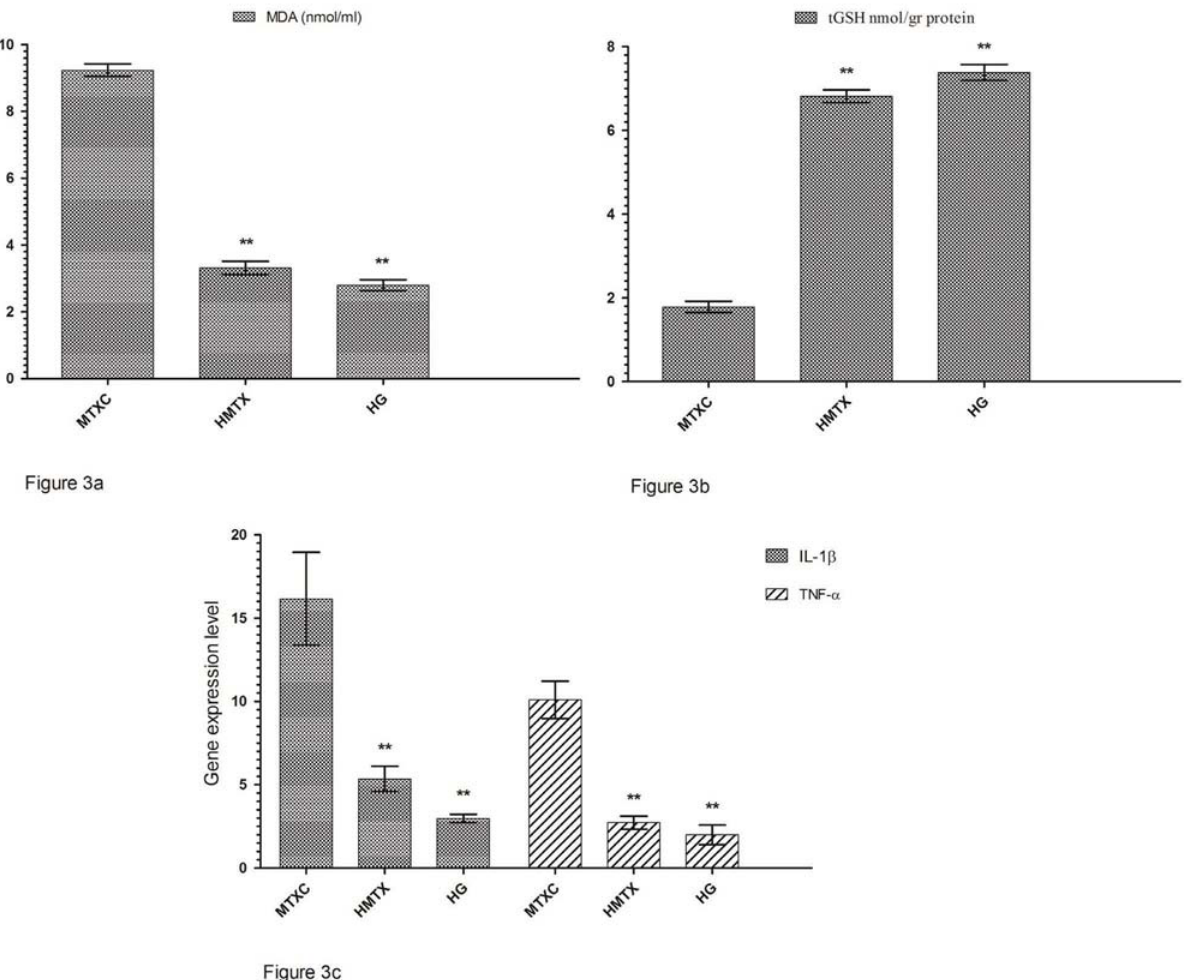
Figure 3- a: The effects of methotrexate on malondialdehyde (MDA) levels in the tongue tissues; b: The effects of (cid:80)(cid:72)(cid:87)(cid:75)(cid:82)(cid:87)(cid:85)(cid:72)(cid:91)(cid:68)(cid:87)(cid:72)(cid:3)(cid:82)(cid:81)(cid:3)(cid:87)(cid:42)(cid:54)(cid:43)(cid:3)(cid:79)(cid:72)(cid:89)(cid:72)(cid:79)(cid:86)(cid:3)(cid:76)(cid:81)(cid:3)(cid:87)(cid:75)(cid:72)(cid:3)(cid:87)(cid:82)(cid:81)(cid:74)(cid:88)(cid:72)(cid:3)(cid:87)(cid:76)(cid:86)(cid:86)(cid:88)(cid:72)(cid:86)(cid:30)(cid:3)(cid:70)(cid:29)(cid:3)(cid:55)(cid:75)(cid:72)(cid:3)(cid:72)(cid:73)(cid:73)(cid:72)(cid:70)(cid:87)(cid:86)(cid:3)(cid:82)(cid:73)(cid:3)(cid:80)(cid:72)(cid:87)(cid:75)(cid:82)(cid:87)(cid:85)(cid:72)(cid:91)(cid:68)(cid:87)(cid:72)(cid:3)(cid:82)(cid:81)(cid:3)(cid:44)(cid:47)(cid:16)(cid:20)(cid:533)(cid:3)(cid:74)(cid:72)(cid:81)(cid:72)(cid:3)(cid:72)(cid:91)(cid:83)(cid:85)(cid:72)(cid:86)(cid:86)(cid:76)(cid:82)(cid:81)(cid:3)(cid:79)(cid:72)(cid:89)(cid:72)(cid:79)(cid:3)(cid:76)(cid:81)(cid:3)(cid:87)(cid:75)(cid:72)(cid:3) tongue tissues.